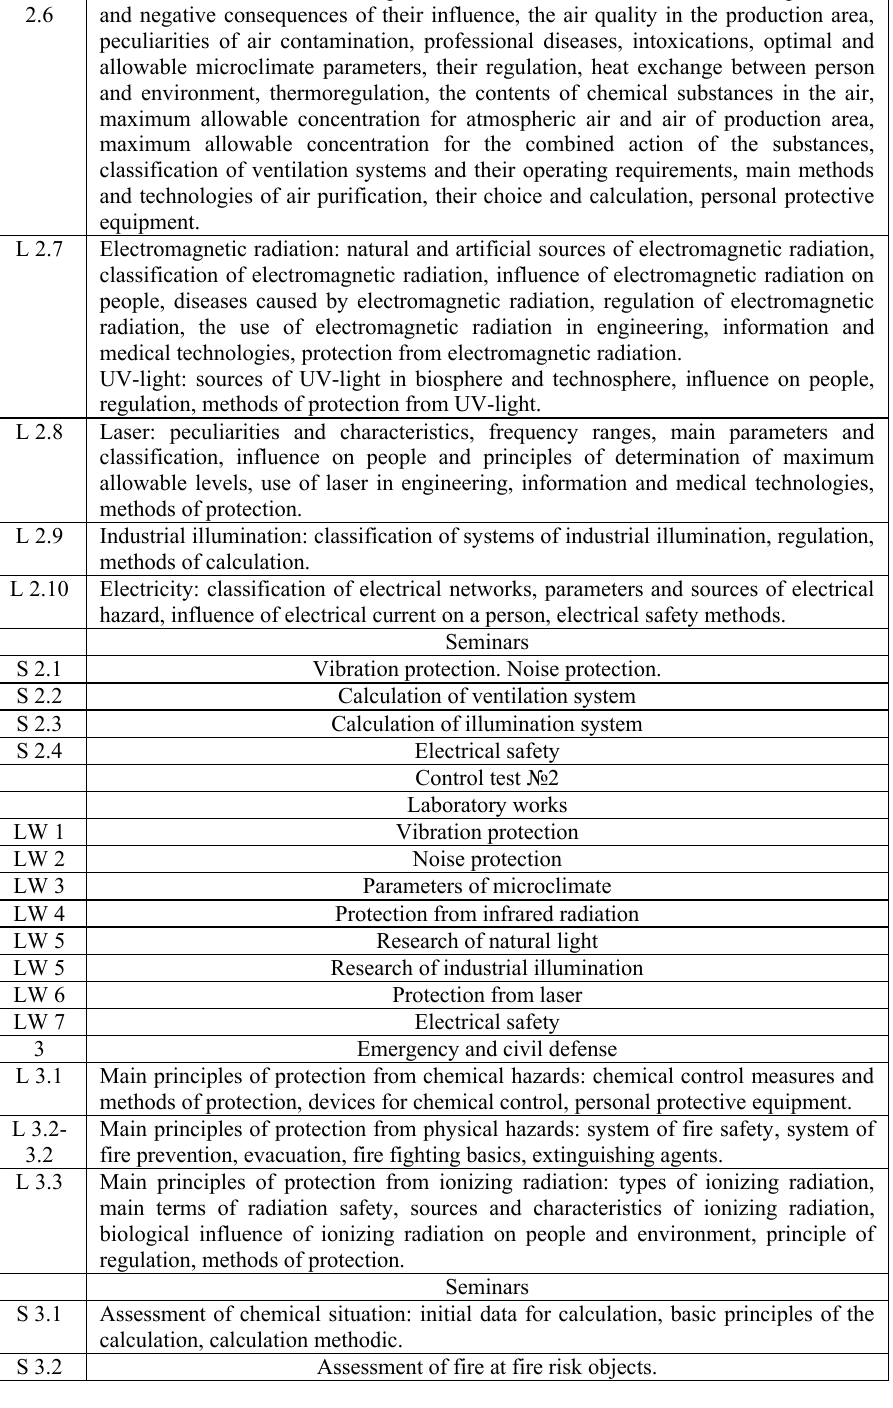
Table 1. (Continued) The contents of the discipline «Life